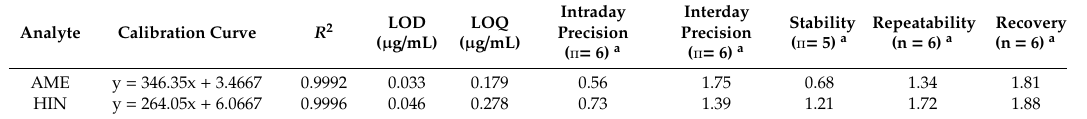
Table 4. Method validation for two standard